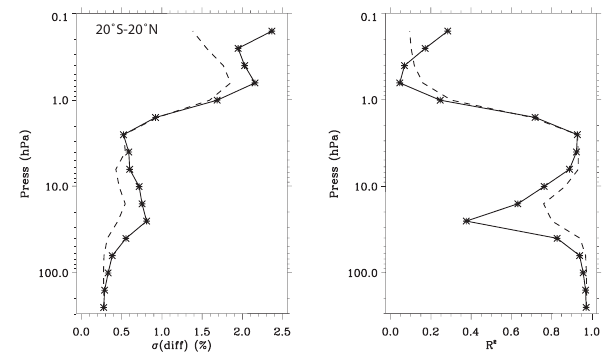
Figure 19. Same as in Fig. 12 but for tropics (20S-20N). Smoothing has small effect Fig. 19. Same as in Fig. 12 but for tropics (20 ◦ S–20 ◦ N). Smooth- except near 20 hPa, where errors caused by the distortion of QBO phase are still ing has small effect except near 20hPa, where errors caused by the significant. distortion of QBO phase are still